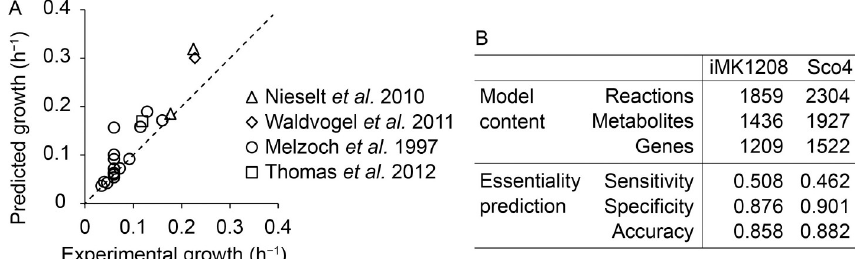
Fig 5. Growth and gene essentiality prediction of Sco4. (A) Comparison of experimental growth rate and predicted growth rate of published bioreactor cultivations [37], using reported exchange rates as model constraints. (B) Comparison between the previously curated GEM iMK1208 and Sco4, of network characteristics and results from single-gene non-essentiality predictions, based on a mutagenesis study by [38].